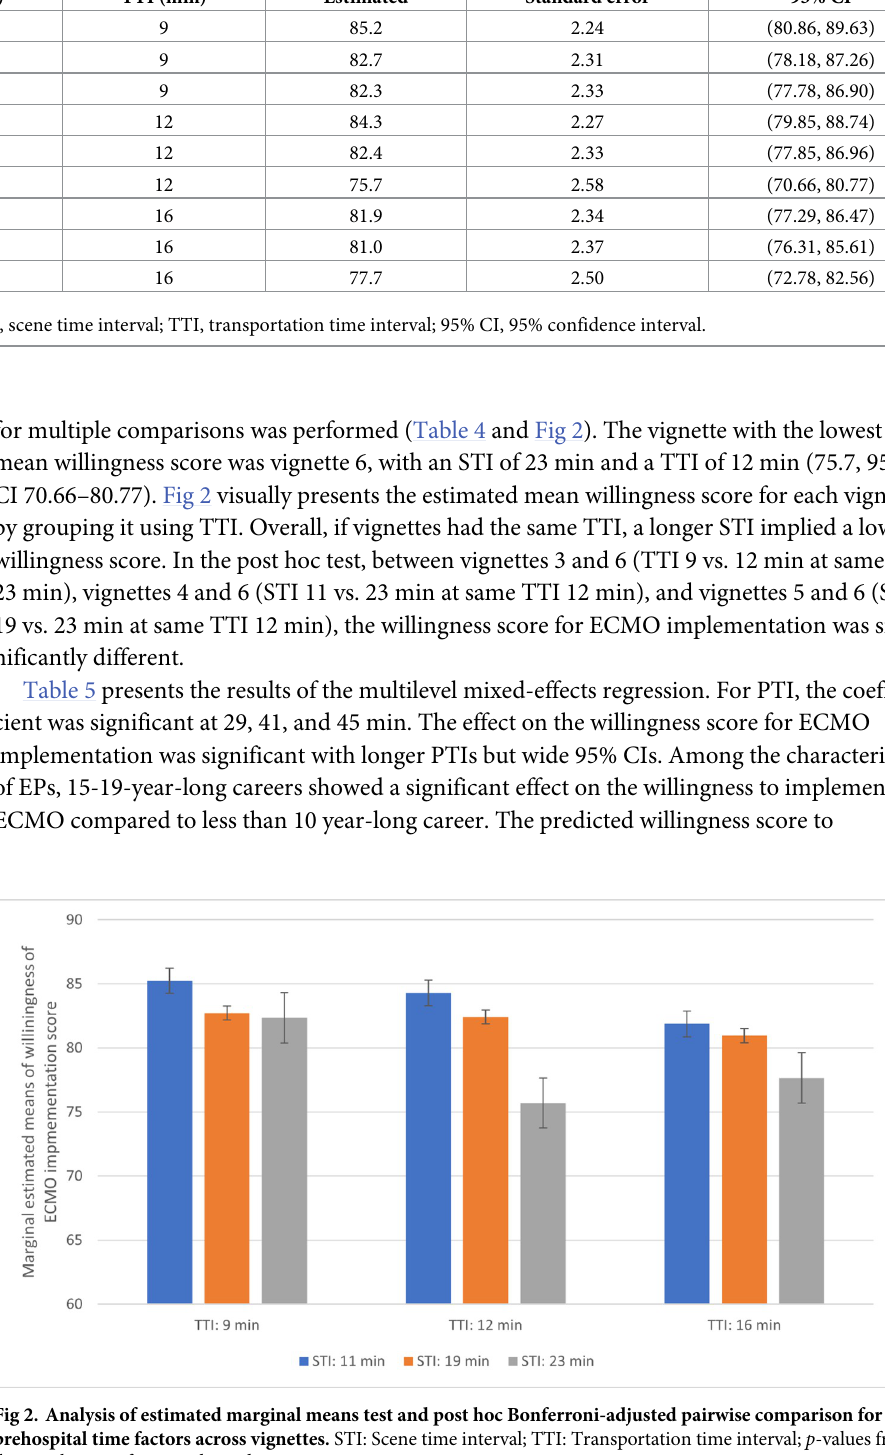
Table 4. Analysis of estimated marginal means of willingness score for ECMO implementation for each vignette.